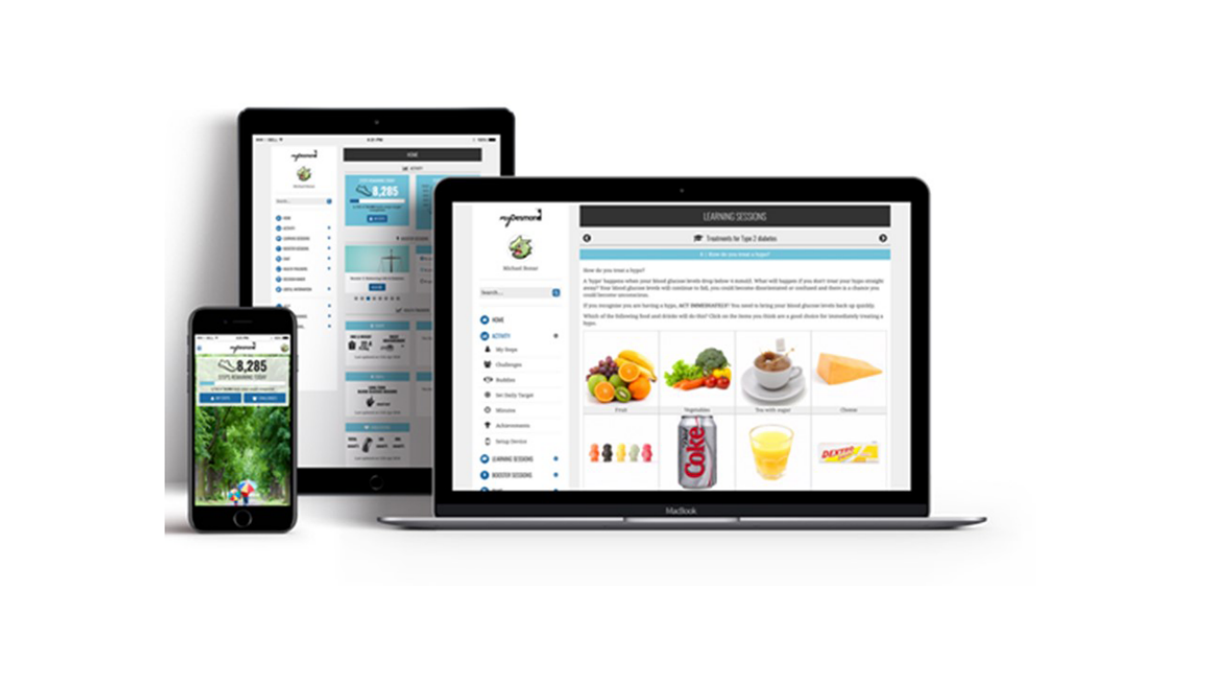
Figure 7. MyDESMOND operates like a native